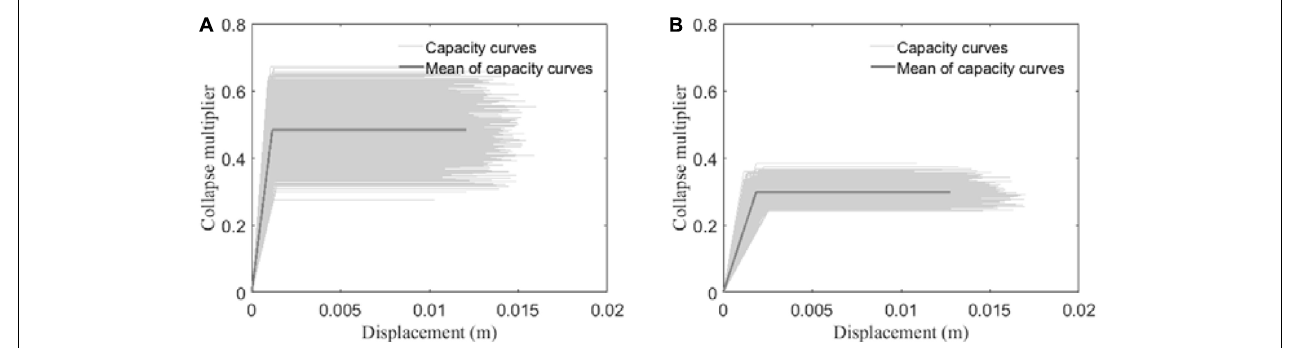
FIGURE 8 | Capacity curves associated with in-plane mechanisms: (A) one- and (B) two-story adobe dwellings.